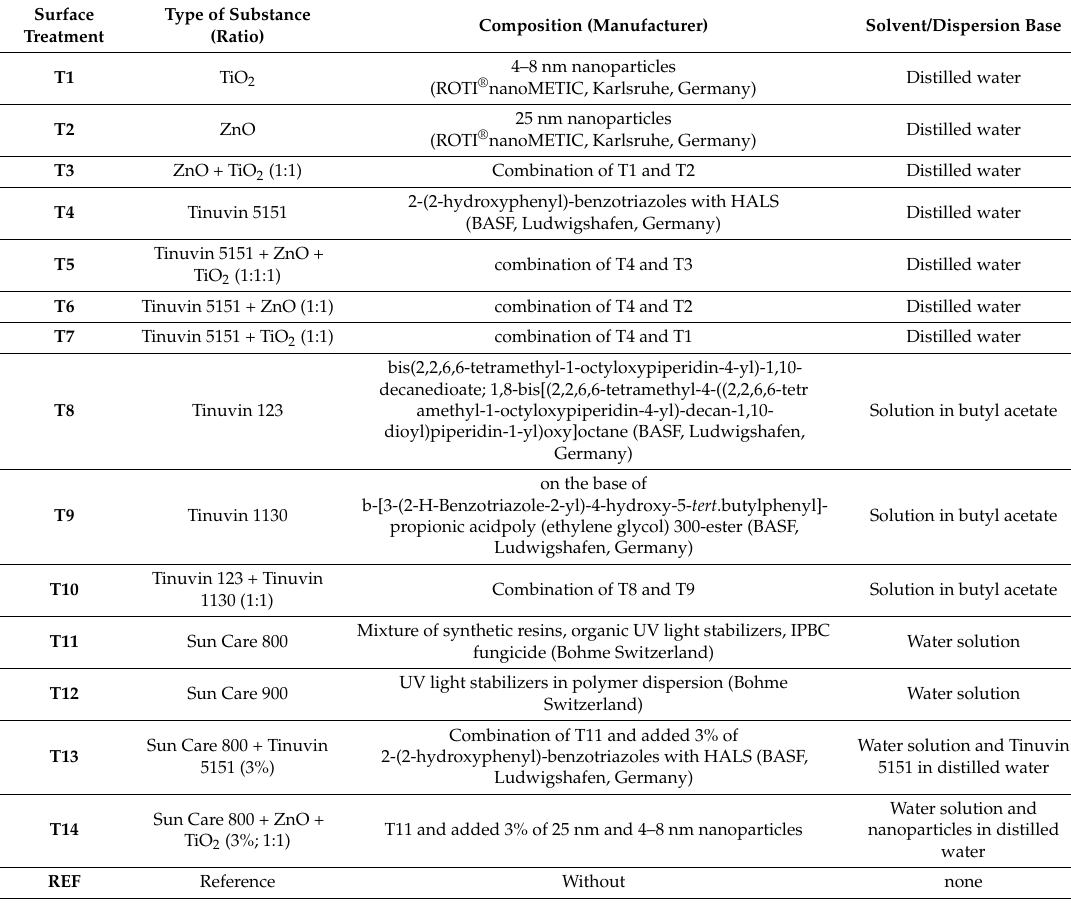
Table 2. Composition of surface penetration layers on